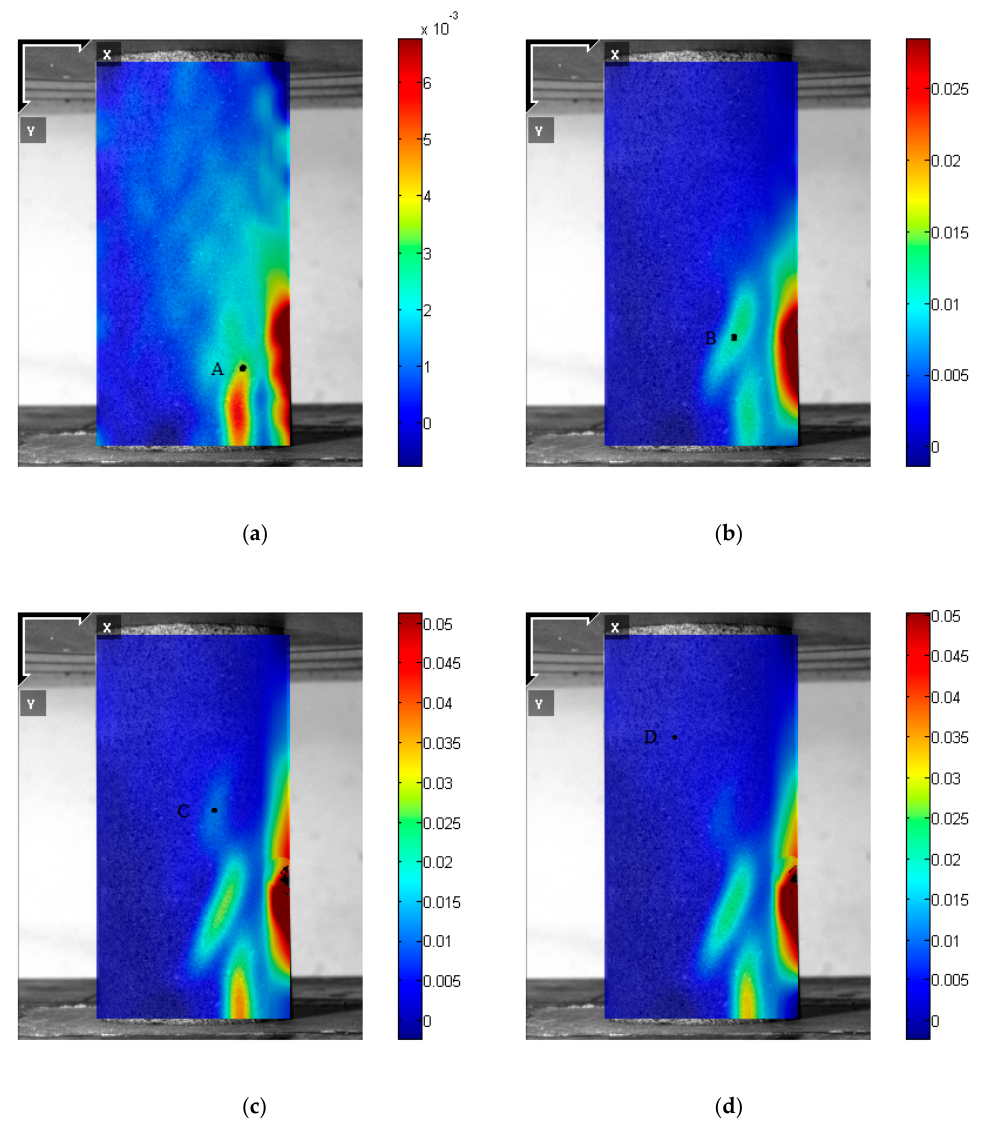
Figure 12. Strain dynamics along the x-direction (loading rate = 0.3 MPa/s): ( a ) 58 s; ( b ) 71.5 s; ( c ) 72.5 s; ( d ) 78 s.